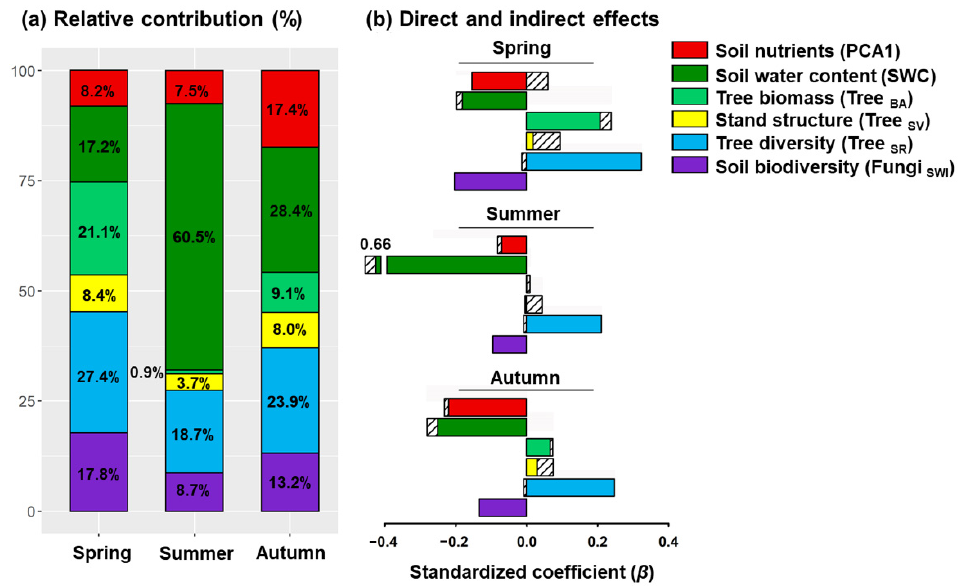
Figure 3. Relative contributions ( a ), and direct and indirect effects ( b ) of significant predictors to soil respiration rates in different seasons. Solid colours represent direct effects derived from structural equation models, whereas striped bars represent indirect effects (see also Table S6).